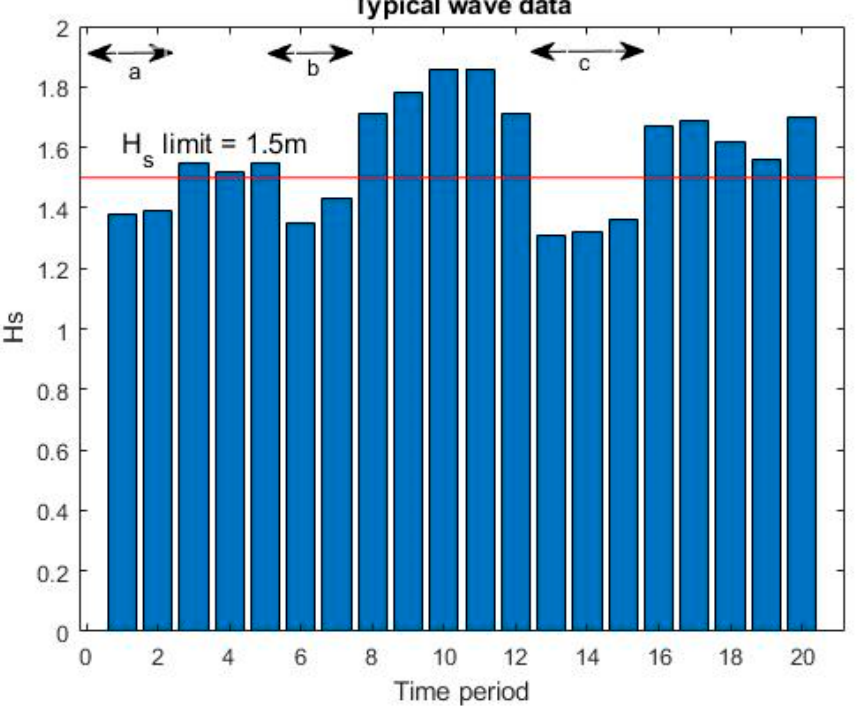
Figure 2. Summary of the research process [11]. The wave data collected were ERA5 reanalysis data, which is produced by the Euro- pean Centre for Medium Range Weather Forecasts (ECMWF). ERA5 uses historical real world weather data (i.e., satellite and weather buoy data) combined with advanced mod- elling to generate detailed weather data sets that can be used in climatological studies [26].